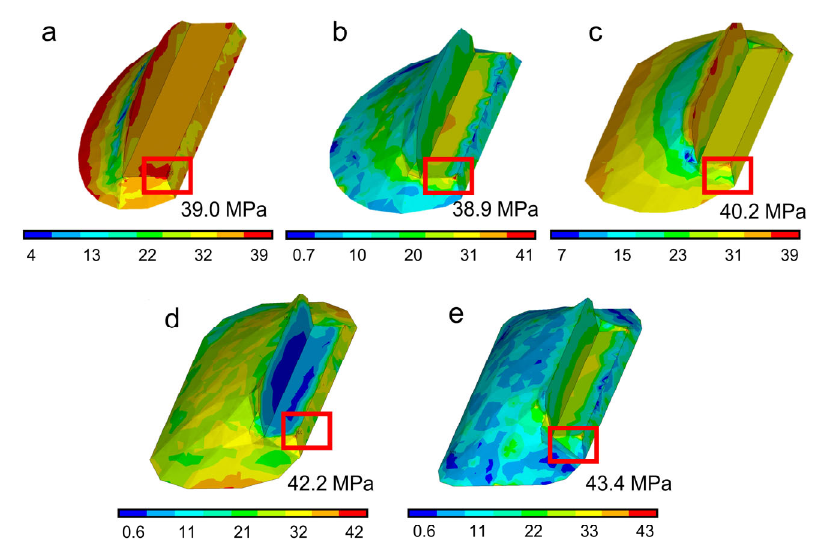
Figure 4. Stress distribution of solder joints at the lowest temperature with the solder volume of ( a ) 0.025 mm 3 , ( b ) 0.05 mm 3 , ( c ) 0.075 mm 3 , ( d ) 0.1 mm 3 , ( e ) 0.125 mm 3 .